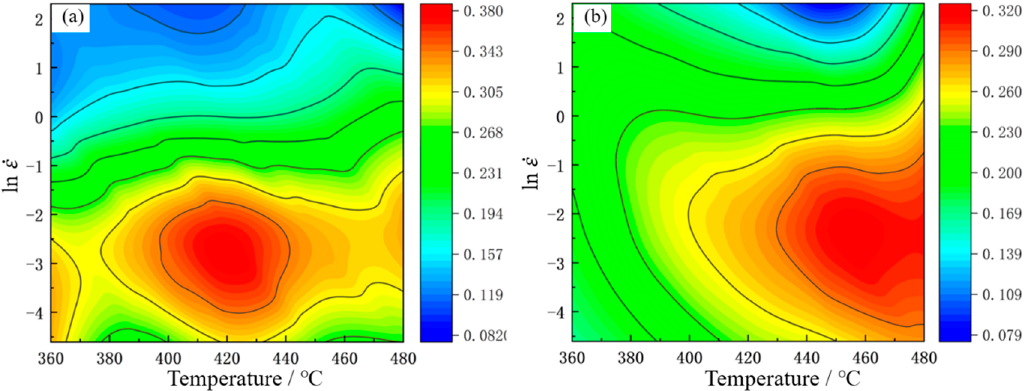
Figure 5. Power dissipation efficiency maps of AC and HG AA2195 Al-Li alloys under different thermal deformation conditions: ( a ) AC 2195 Al-Li alloy, ( b ) HG 2195 Al-Li alloy.